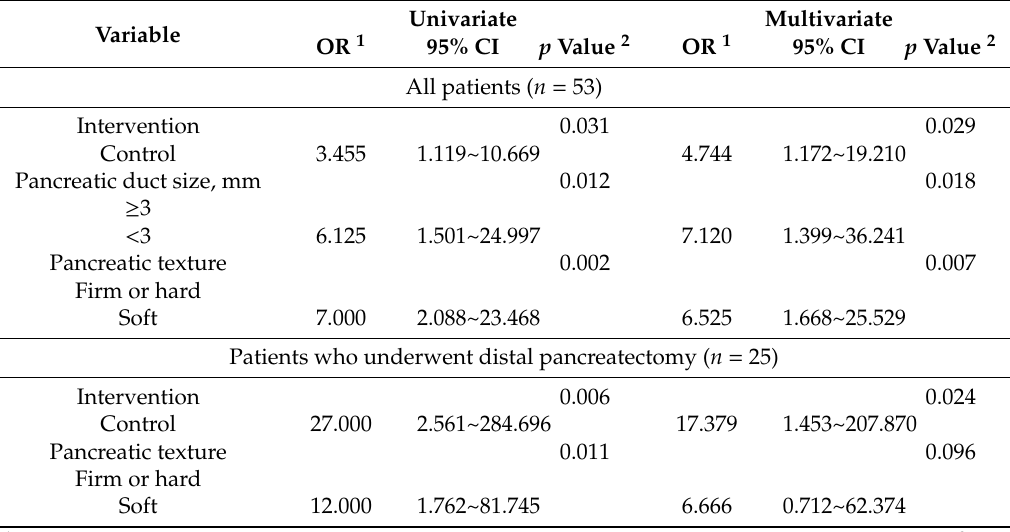
Table 4. Univariate and multivariate logistic regression analyses of risk factors for postoperative pancreatic